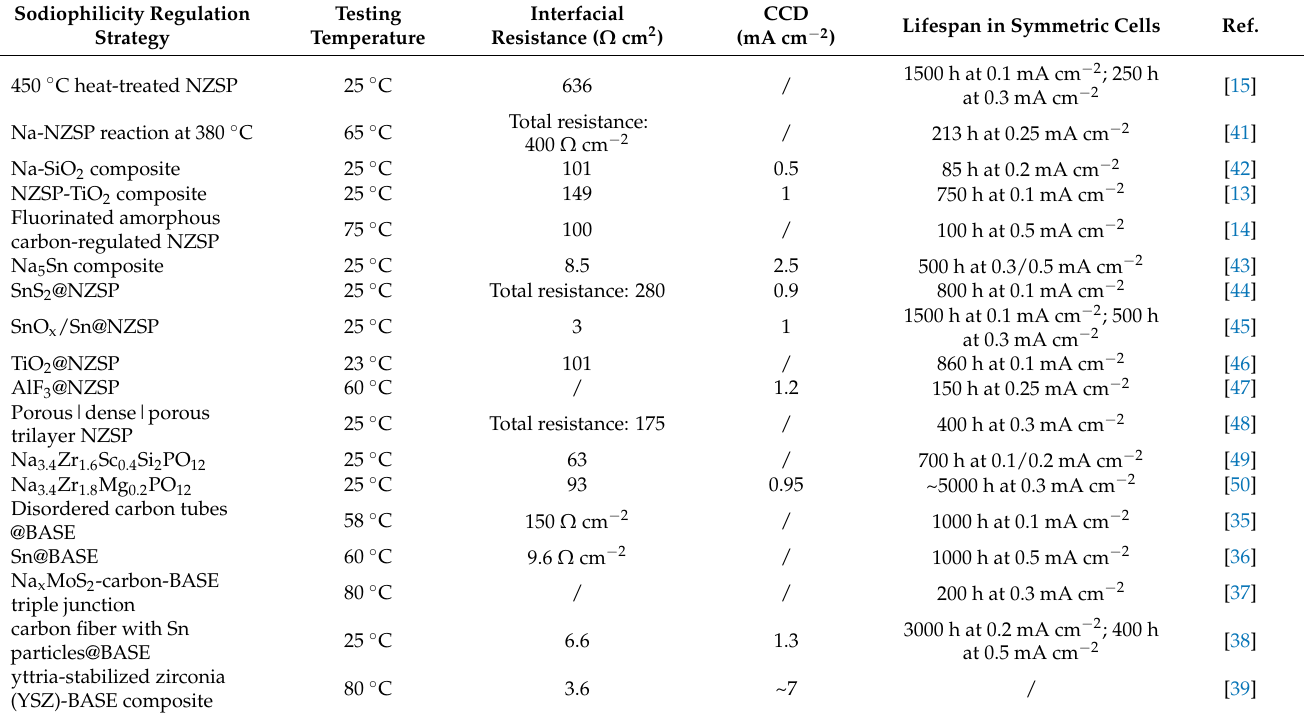
Table 1. Comparison of symmetric-cell electrochemical performance of all-solid-state sodium-metal batteries modified with various wetting